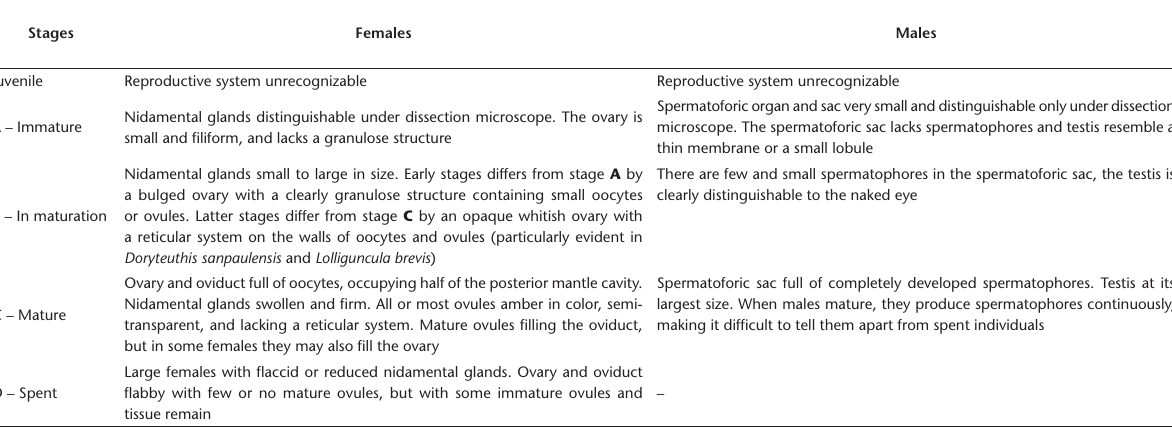
Table 1. Juanicó’s (1983) loliginid squid maturity